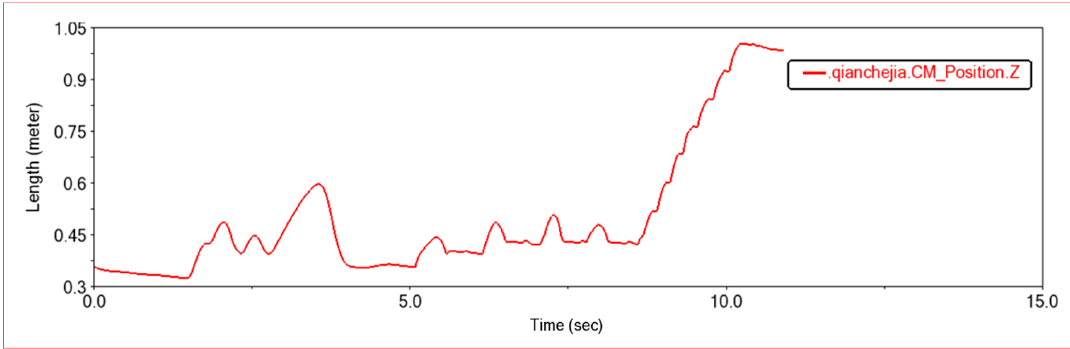
Figure 8. The trajectory diagram of the center of mass of the front frame.